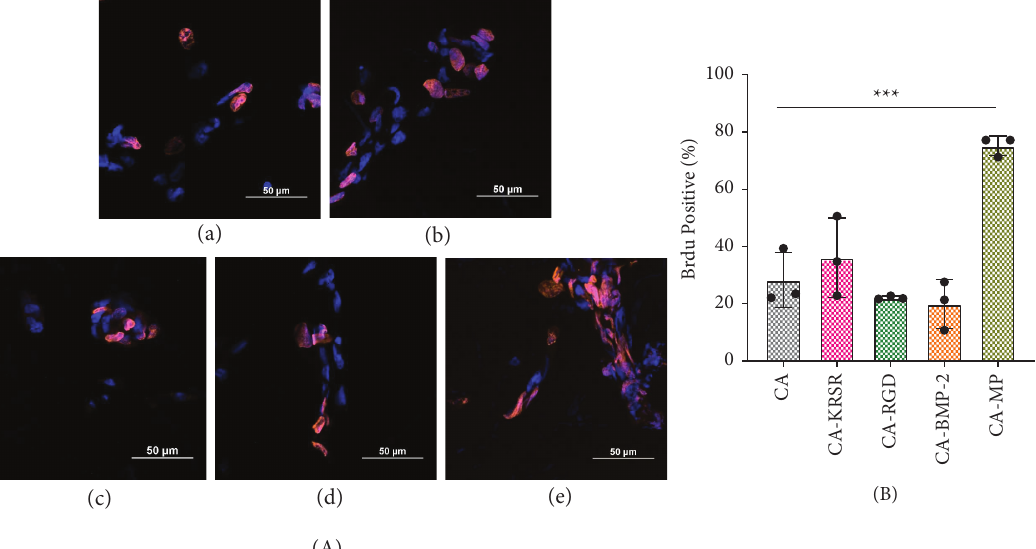
Figure 5: (a) hFOB 1.19 BrdU cell proliferation assay against each CA electrospun mat. Blue nuclei represent total cells, and orange overlap represents the BrdU-incorporated nuclei in (A) CA fiber mat, (B) CA-KRSR, (C) CA-RGD, (D) CA-BMP-2, and (E) CA-MP. Scale bar represents 50 µ m. (b) BrdU-positive cells in each treated fiber mat.